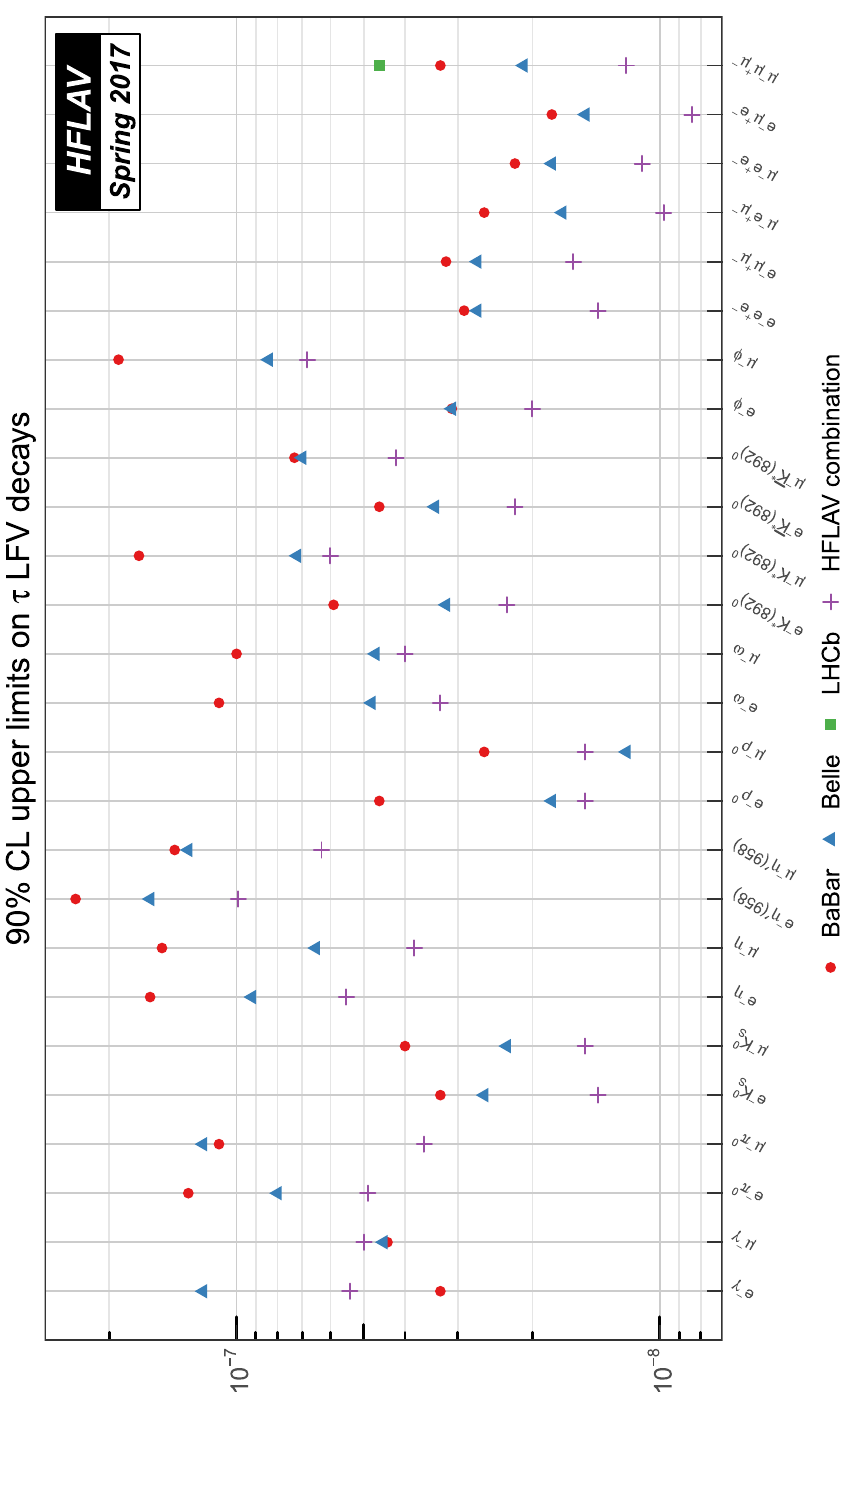
Fig. 222 Tau lepton-flavour-violating branching fraction upper limits combinations summary plot. For each channel we report the HFLAV combined limit, and the experimental published limits. In some cases, the combined limit is weaker than the limit published by a single experiment. This arises since the CL s method used in the combination can be more conservative compared to other legitimate methods, especially when the number of observed events fluctuates below the expected